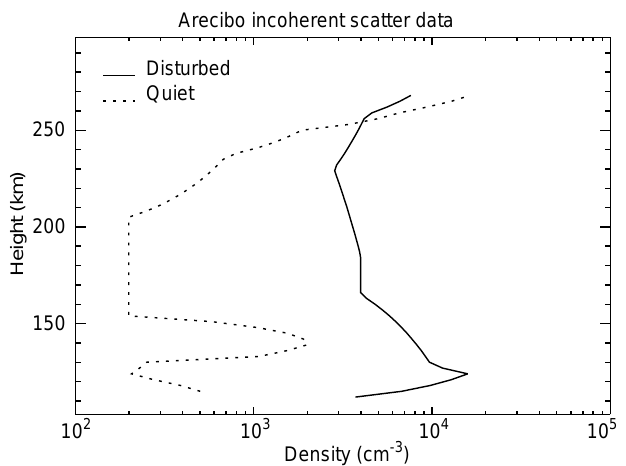
Fig. 1. Electron density profiles observed at Arecibo during the mag- netically quiet night of November 29, 1972 (Kp » 2) and during the magnetically disturbed night of October 31, 1972 (Kp » 8). The time of observation was 23:30 LT (Rowe,